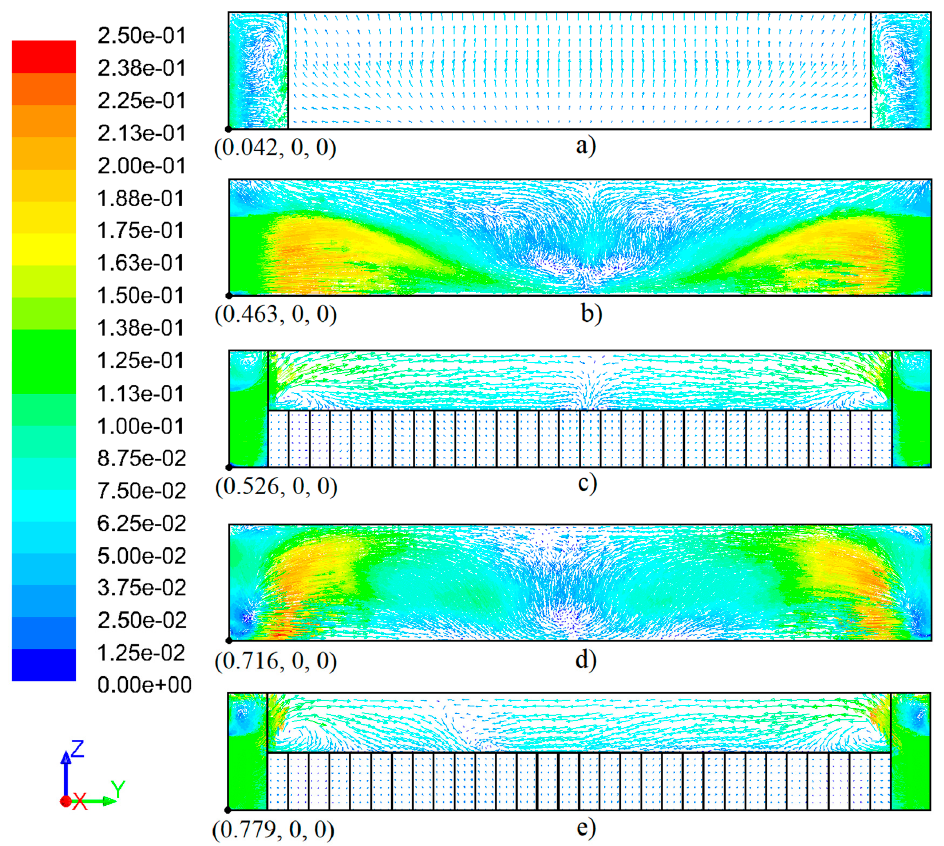
Figure 22. The results of the dimensionless velocity vectors for the minimum air flow velocity in the y-z plane represented through the planes: ( a ) x adm = 0.042; ( b ) x adm = 0.116; ( c ) x adm = 0.526; ( d ) x adm = 0.589; ( e ) x adm = 0.779; and ( f ) x adm = 0.842. Appl. Sci. 2019 , 9 , x FOR PEER REVIEW